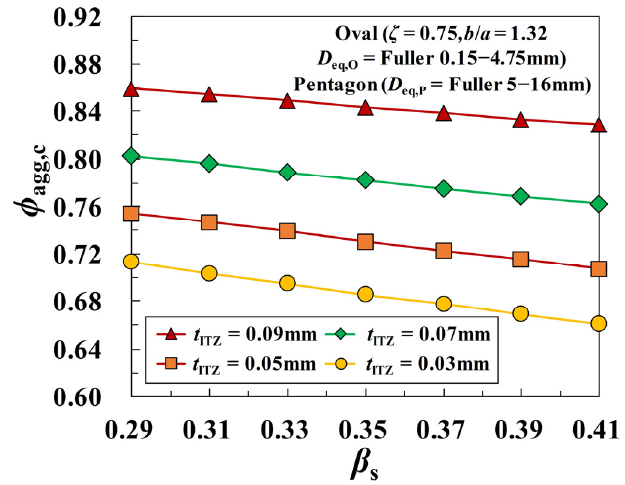
Figure 12. Effect of the sand ratio β s on the ITZ percolation under a constant ITZ thickness.